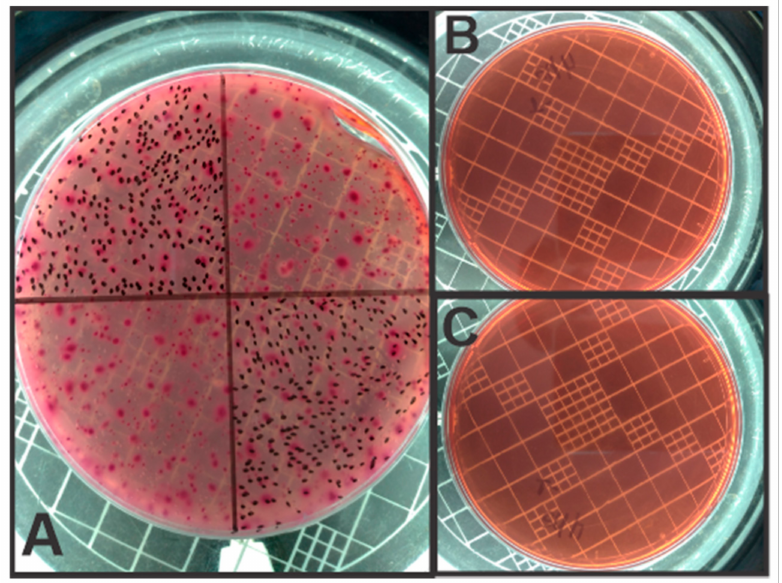
Figure 4. Microbial load of LL: ( A ) Raw LL; ( B ) after 4 h of treatment and ( C ) after 8 h of